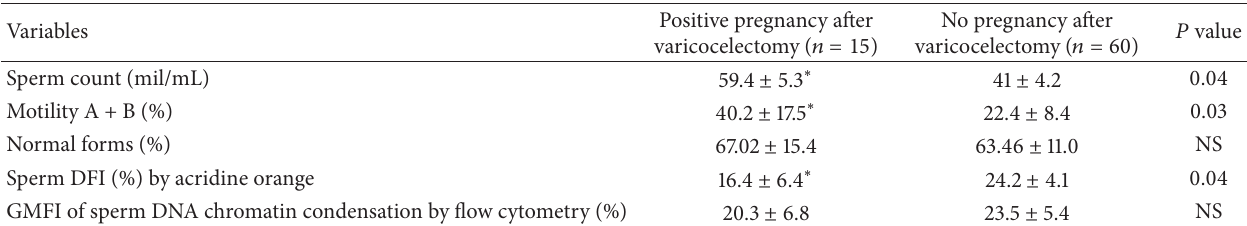
Table 3: Comparison between those who achieved clinical pregnancy and those who failed after varicocelectomy.